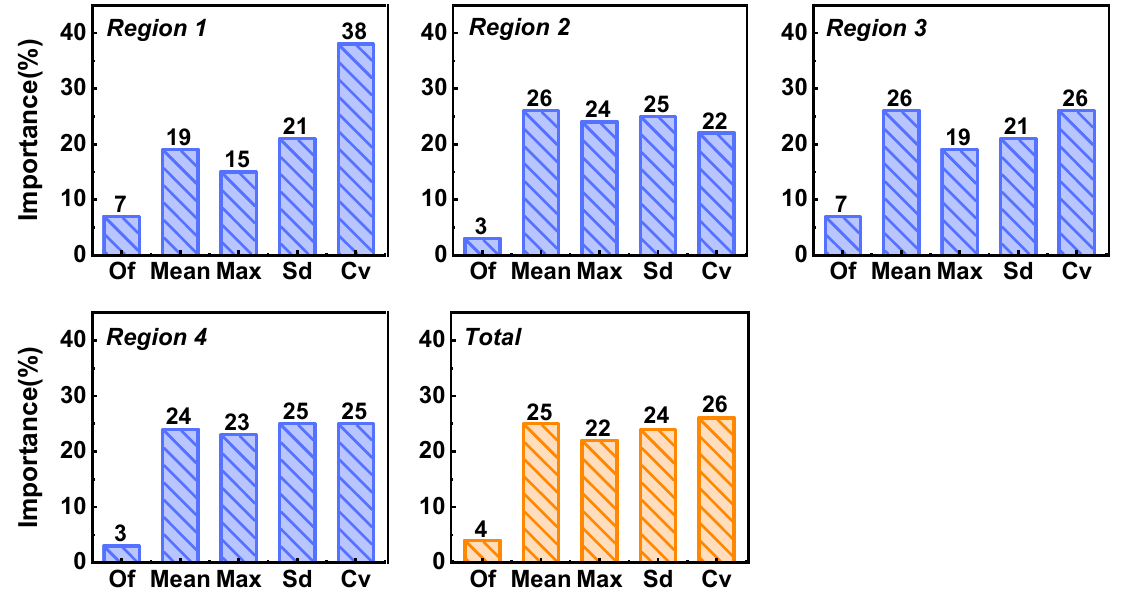
Figure 12. The feature importance of the four experimental areas and their average values.